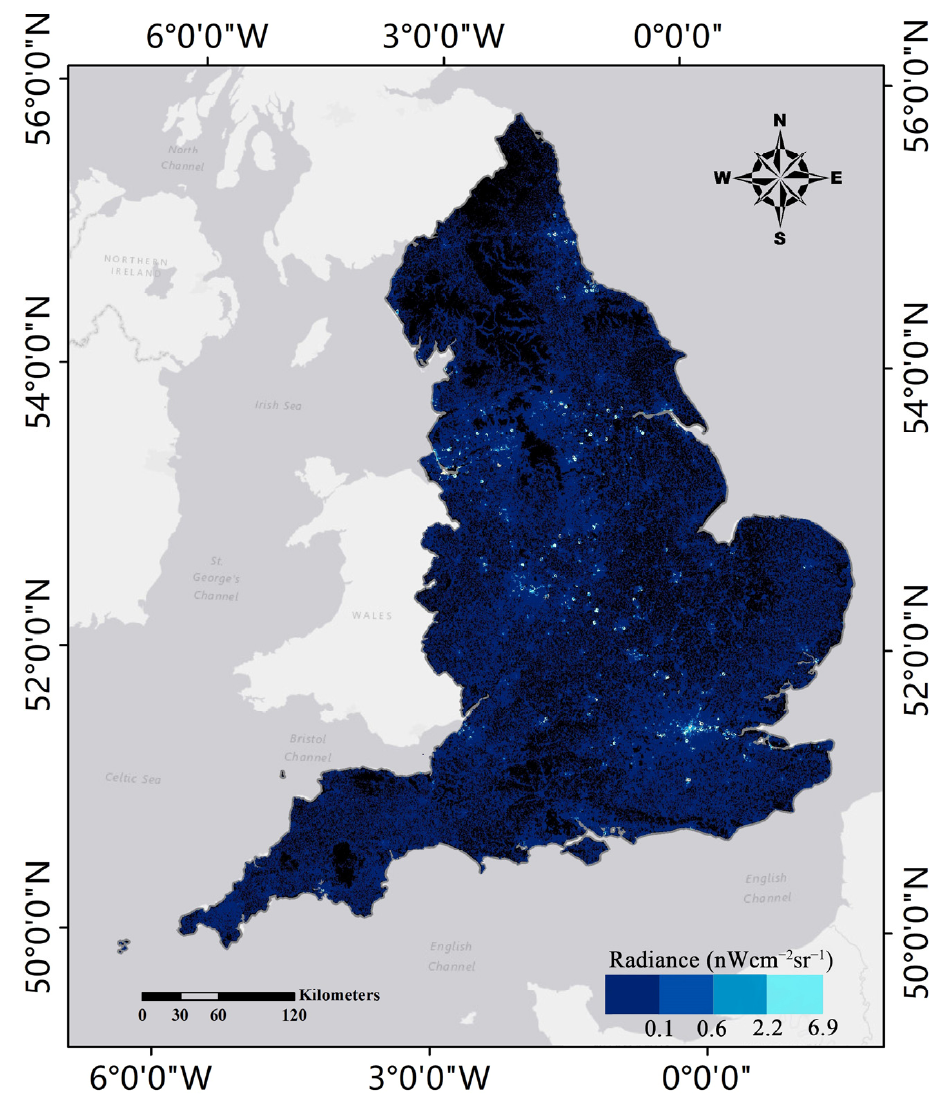
Figure 5. The distribution of single building’s nightlight value in England in January.